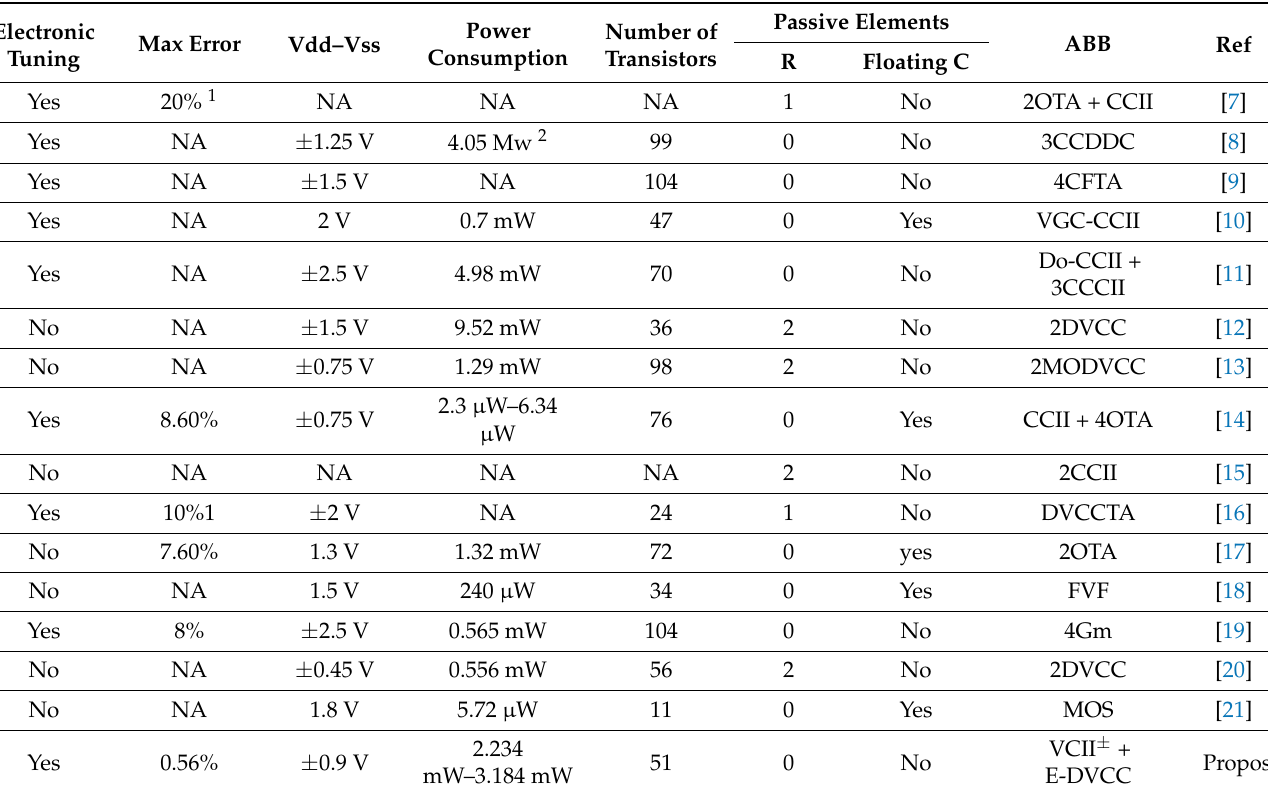
Table 4. Comparison between proposed circuit and other reported